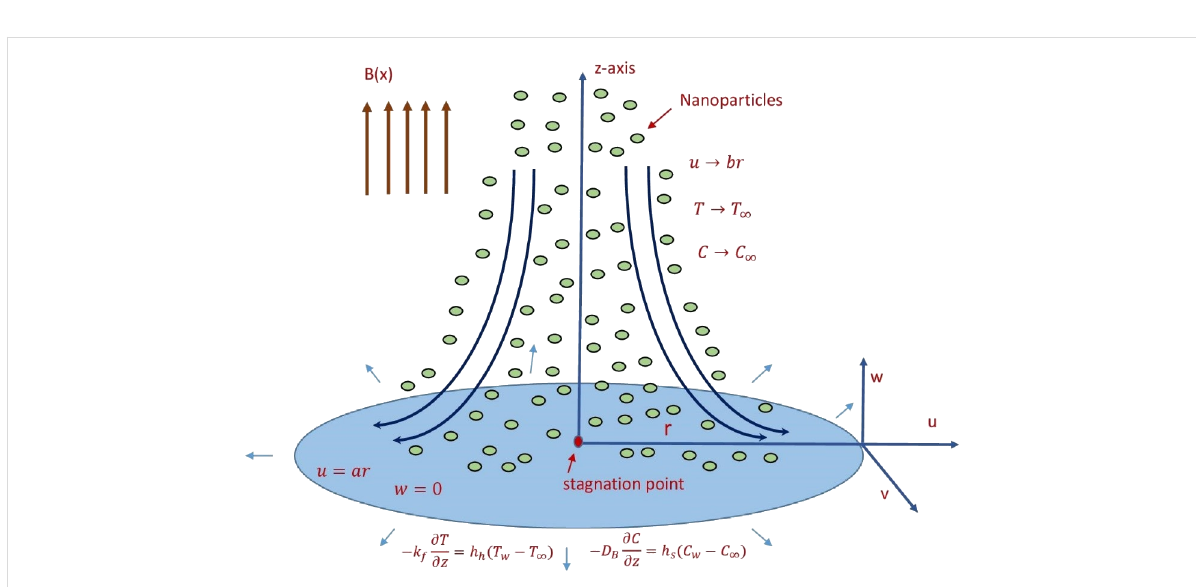
Figure 1: Schematic of the physical model in which a Casson nanofluid is passing a radially stretched surface in the proximity of a stagnation